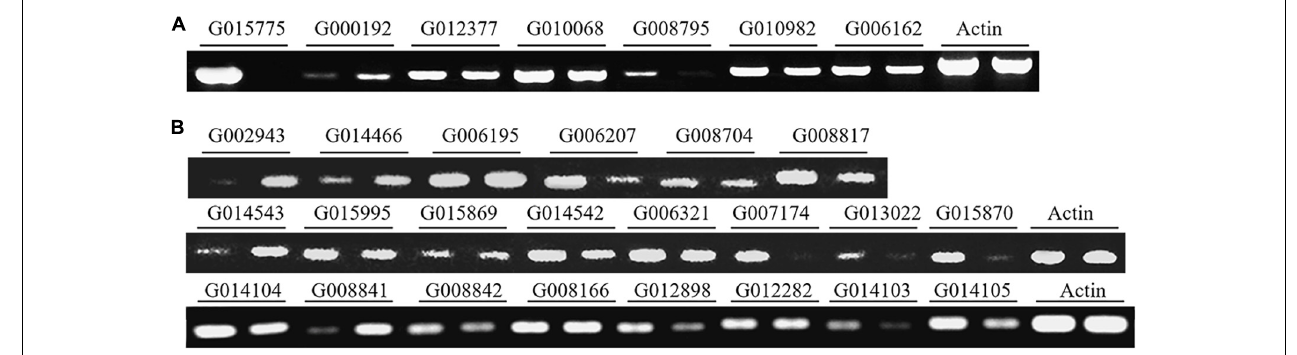
FIGURE 2 | Validation of the transcripts of novel protein-coding genes and lncRNAs with RT-PCR. (A) Seven genes and (B) 22 lncRNAs were expressed in conidia (left lanes) and/or hyphae (right lanes). The actin gene was used as a control.